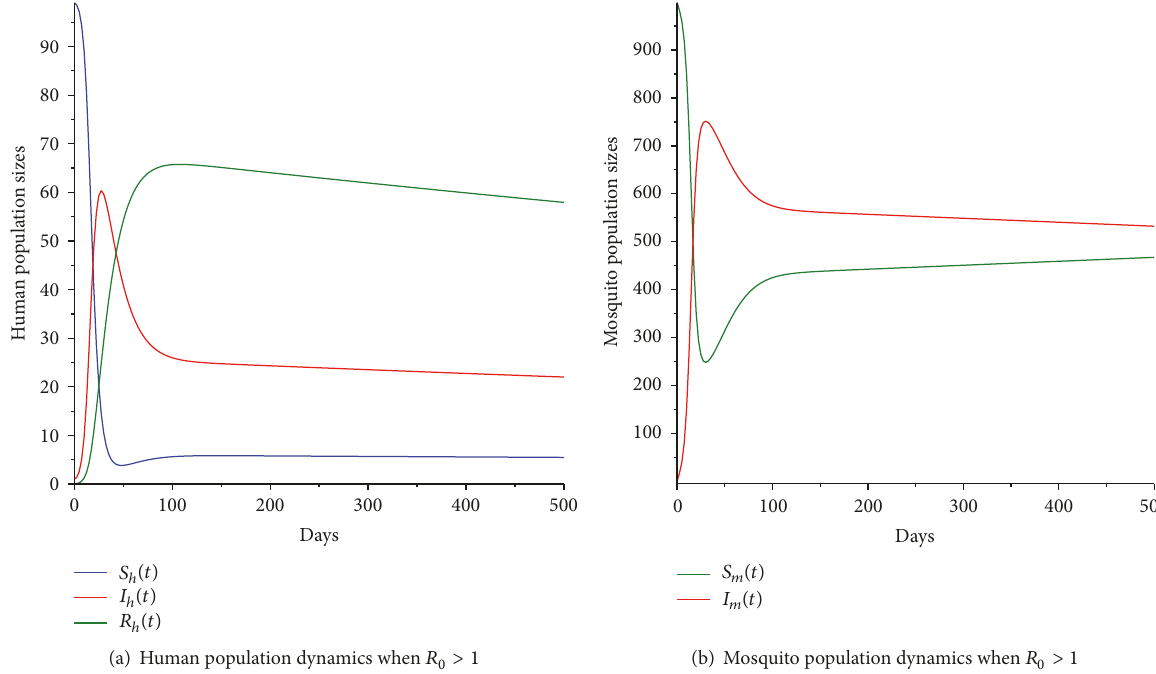
Figure 6: Malaria dynamics when 𝑅 0 = 2.4629 and 𝑃 0 = 0.3713